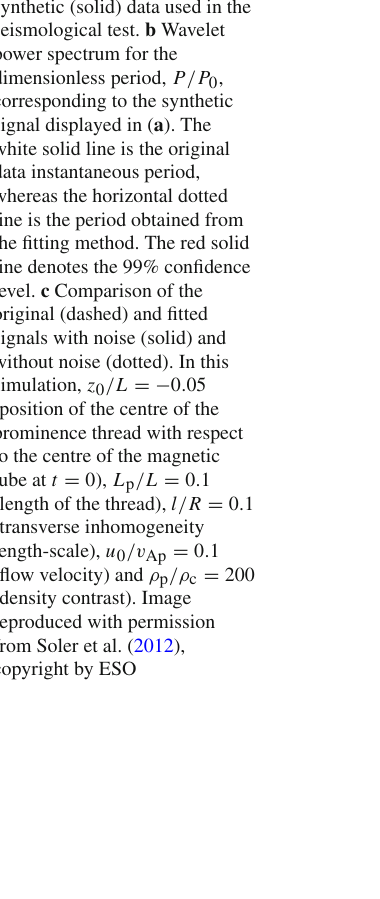
Fig. 91 a Original (dashed) and synthetic (solid) data used in the seismological test. b Wavelet power spectrum for the dimensionless period, P / P 0 , corresponding to the synthetic signal displayed in ( a ). The white solid line is the original data instantaneous period, whereas the horizontal dotted line is the period obtained from the fitting method. The red solid line denotes the 99% confidence level. c Comparison of the original (dashed) and fitted signals with noise (solid) and without noise (dotted). In this simulation, z 0 / L = − 0 . 05 (position of the centre of the prominence thread with respect to the centre of the magnetic tube at t = 0), L p / L = 0 . 1 (length of the thread), l / R = 0 . 1 (transverse inhomogeneity length-scale), u 0 /v Ap = 0 . 1 (flow velocity) and ρ p /ρ c = 200 (density contrast). Image reproduced with permission from Soler et al. (2012), copyright by ESO